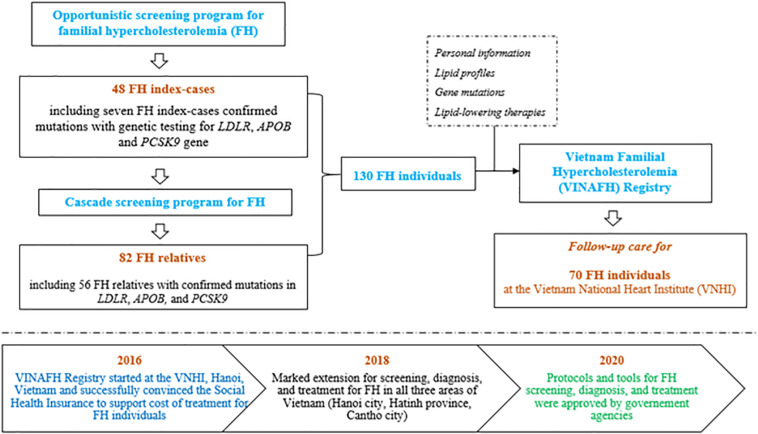
Flow diagram of implementation strategy of the Vietnam Familial Hypercholesterolemia (VINAFH) Registry.